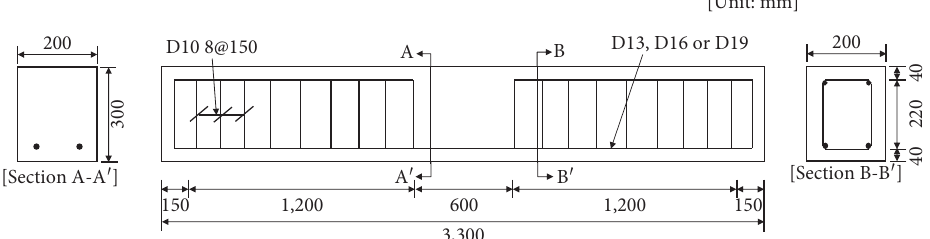
Figure 2: Test beam dimensions.